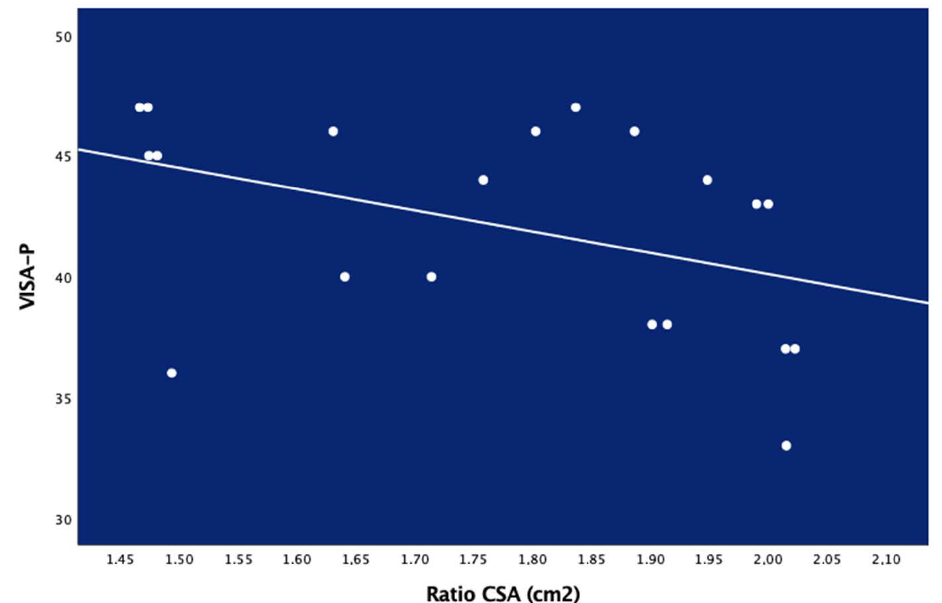
Figure 4. Negative linear association between Cross-Sectional Area (CSA) ratio and related-disability (VISA-P, Victorian Institute of Sport Assessment-Patella score).